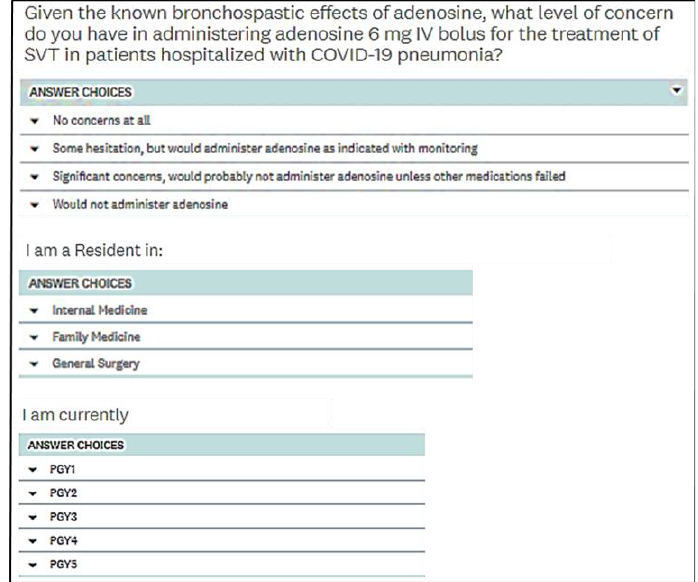
Figure 1. Survey questions sent out to residents.